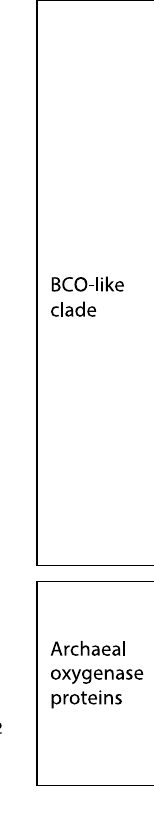
β -apocarotenals while Fusarium carotenoid cleavage enzyme (CCO) CarX and NCS3 Nostoc ACO can cleave β -carotene, torulene and β -Apo-8 ′ -carotenal 12,27–29 .